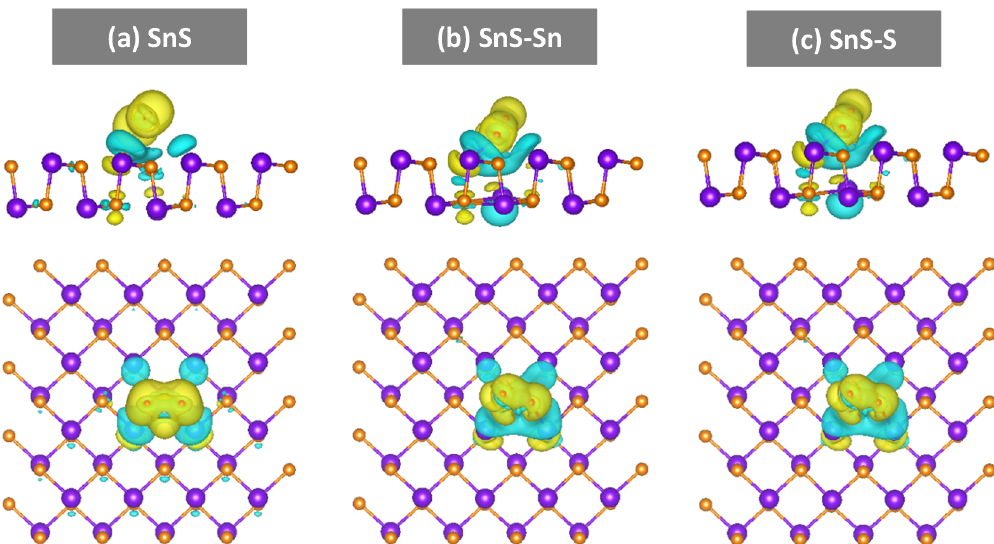
Figure 8. Side-view (top) and top-view (bottom) images showing the charge density difference of NO 2 molecules adsorbed on various SnS monolayer structures: ( a ) SnS, ( b ) SnS-Sn, and ( c ) SnS-S. The yellow and cyan regions represent the areas of electron accumulation and depletion, respectively.